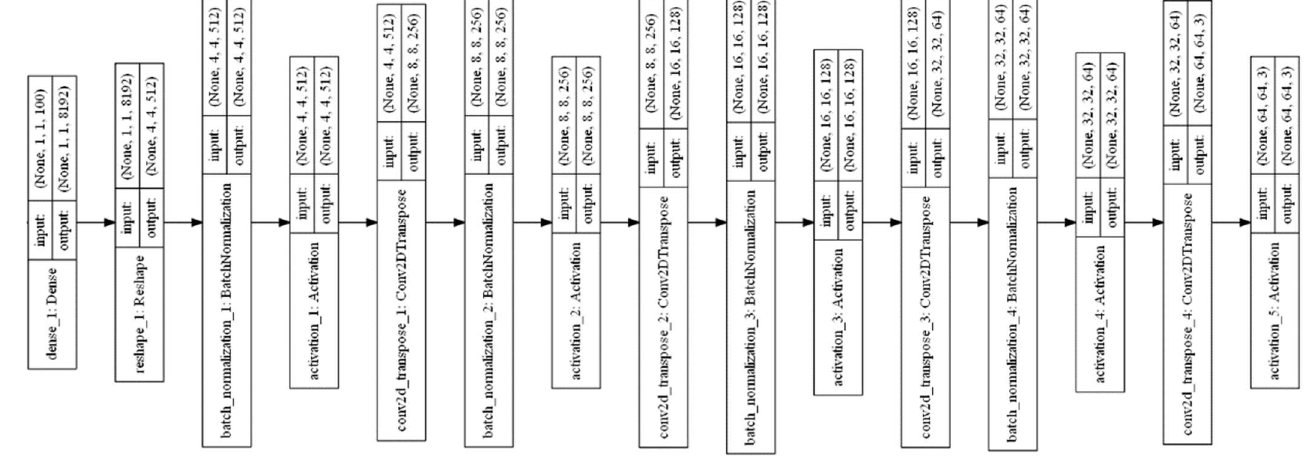
Figure 4. Layered structure of DCGAN generator.